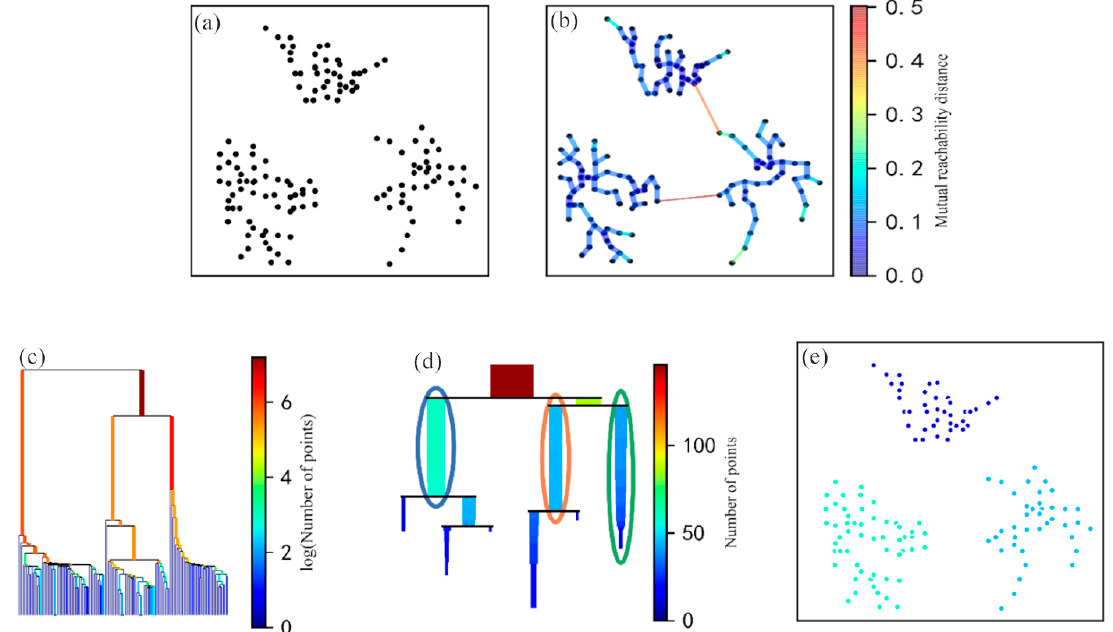
Figure 4. The procedure of applying the hierarchical density-based spatial clustering of applications with noise (HDBSCAN) algorithm: ( a ) root points detected by GPR; ( b ) the minimum spanning tree of mutually accessible distances; ( c ) hierarchy of the minimum spanning tree; ( d ) the condensed hierarchy; ( e ) clustering results extracted from the hierarchy.